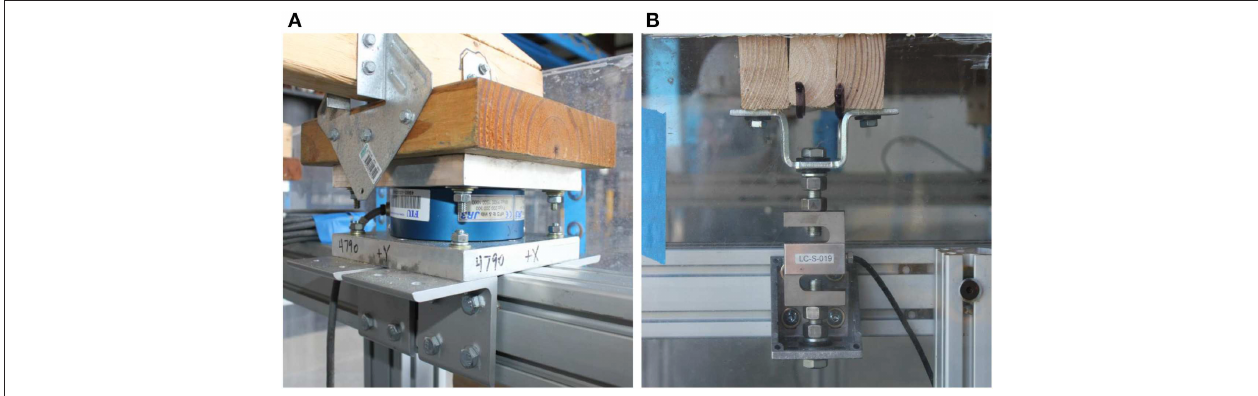
FIGURE 7 | Load cell installation. (A) JR3 6-DOF load cell. (B) Omega S-type uniaxial load